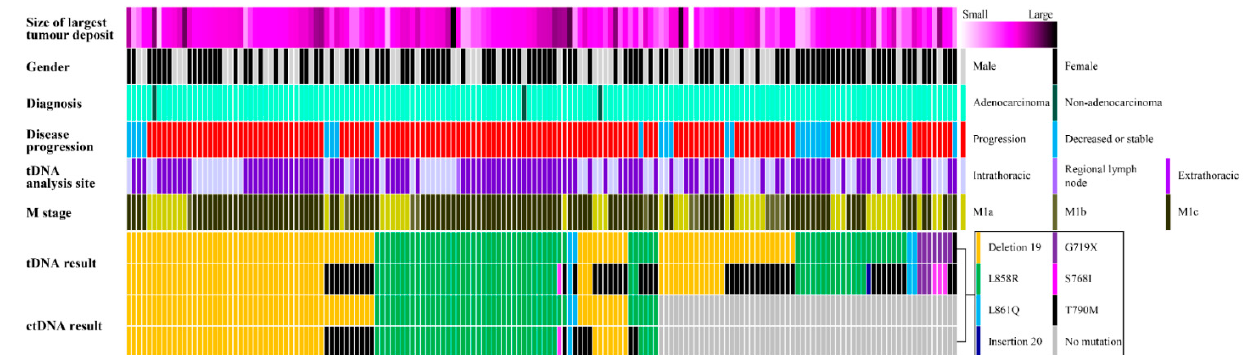
Figure 3. Overview of clinicopathological parameters and the results of the EGFR analysis using tDNA and ctDNA. The figure contains clinicopathological information of the disease progression, size of the largest tumor deposits, gender, the site of tumor tissues used for tDNA analysis, metastasis stage, and the results of tDNA and ctDNA analysis. The T790M mutation was detected in 46 cases in tDNA analysis, with only one patient presenting with this mutation alone. For an appropriate comparison of the detection rate of T790M mutation, we excluded 22 cases of ctDNA-negative cases. After exclusion, 28 ctDNA-positive cases were revealed T790M mutation by either tDNA or ctDNA analysis. The number of cases that revealed T790M mutation was 17 (17/28, 60.7%), and 5 (5/17, 29.4%) cases failed to detect T790M mutation in the tDNA analysis.